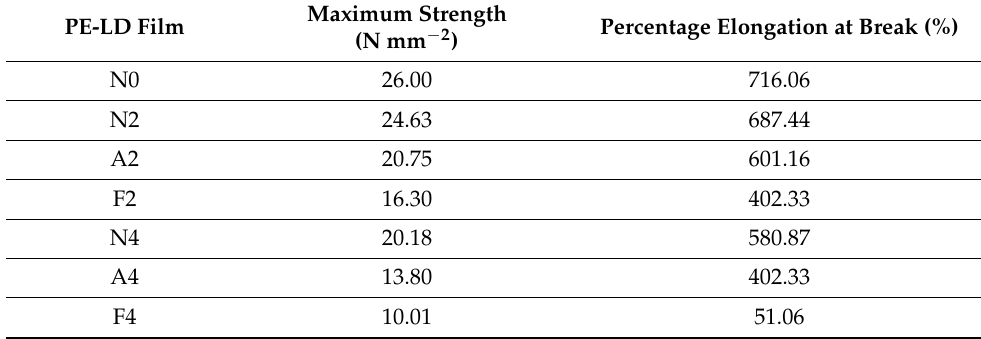
Table 2. Results of the mechanical tests.